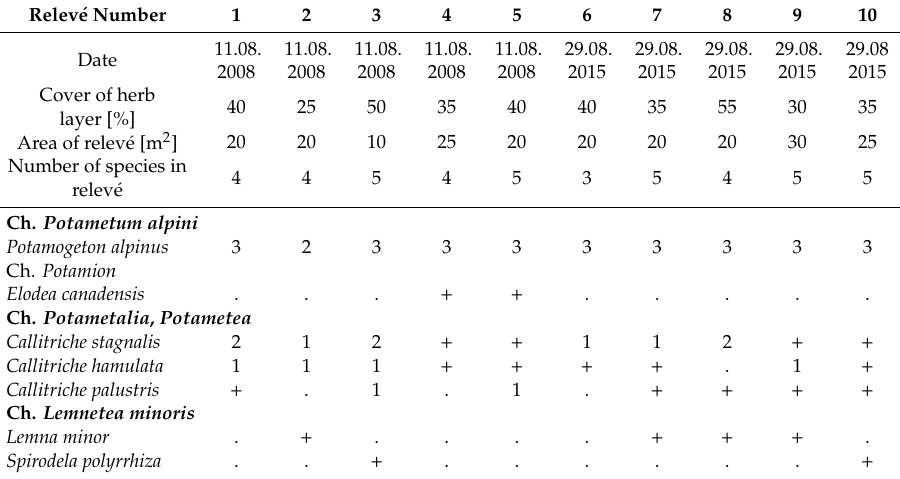
Figure 3. The limnocrene karst spring in Poland with Potametum alpini. Table 1. Potametum alpini Podbielkowski 1967 in the limnocrene karst spring.